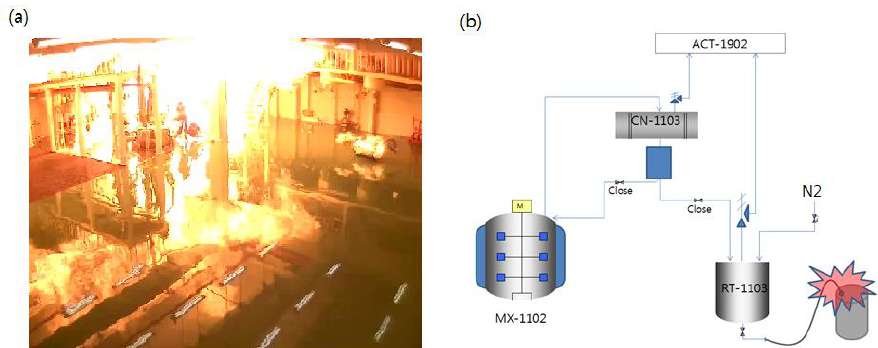
Figure 6. ( a ) Violent fire due to uninformed utilization of 1,4-dioxane and ( b ) schematic of the accident process.